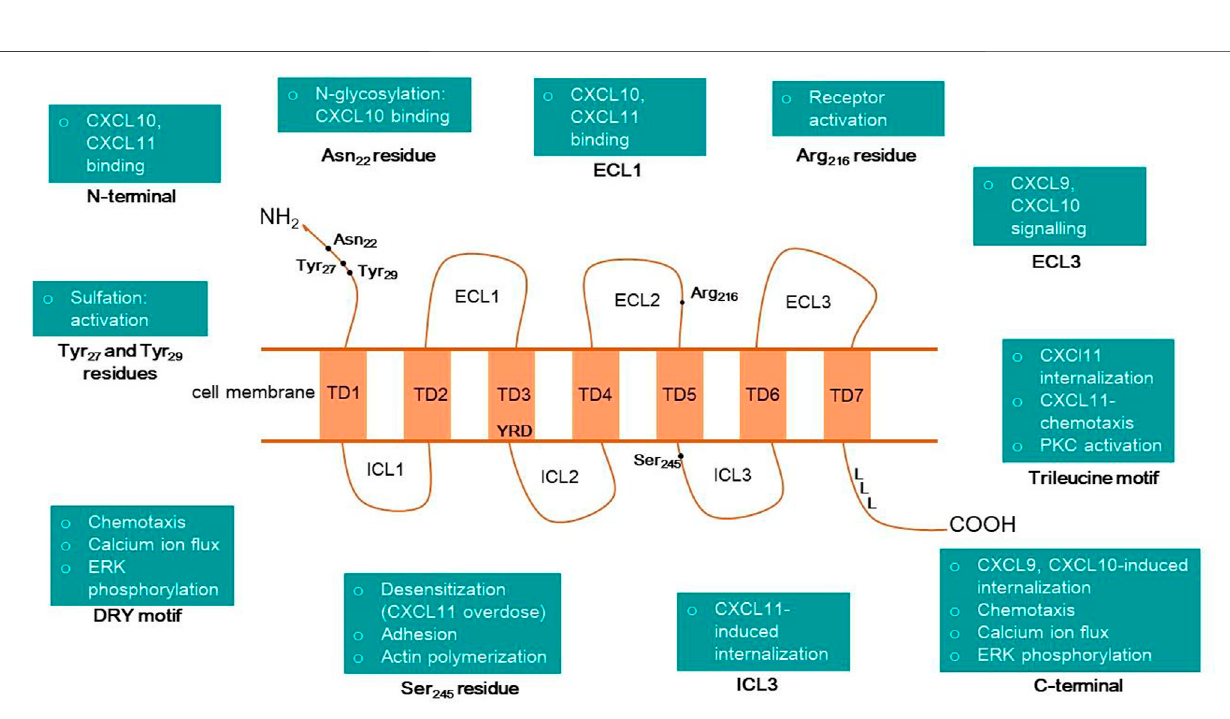
Frontiers in Cell and Developmental Biology |